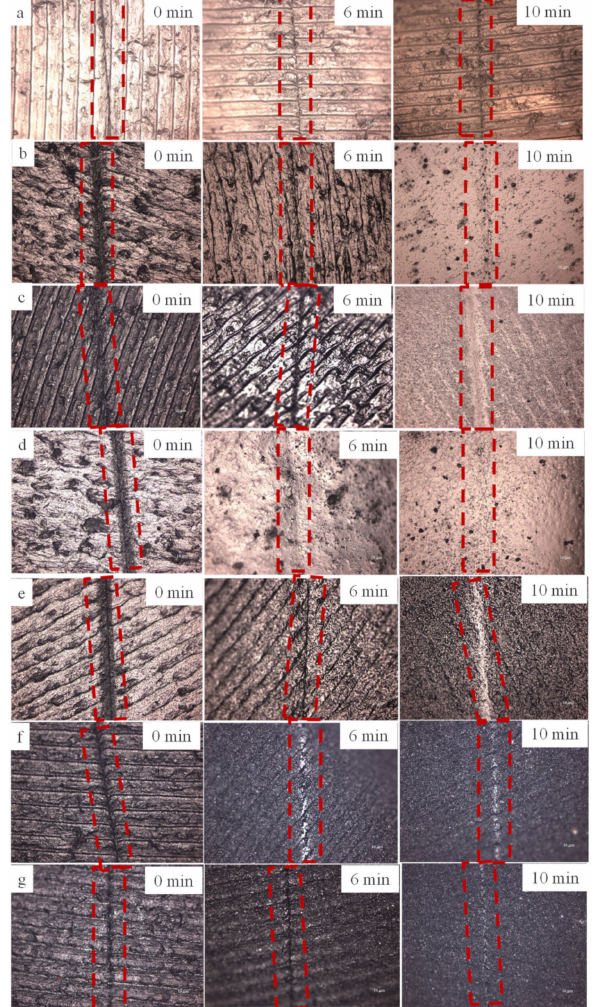
Figure 9. Optical micrographs of the pure TPU ( a ) and the composite films prepared with 20 wt% of TPU and graphene loadings of 0.6 wt% ( b ), 1 wt% ( c ), 2 wt% ( d ), 3 wt% ( e ), 4 wt% ( f ) and 5 wt% ( g ) with scratch under near-IR irradiation for 0, 6 and 10 min,